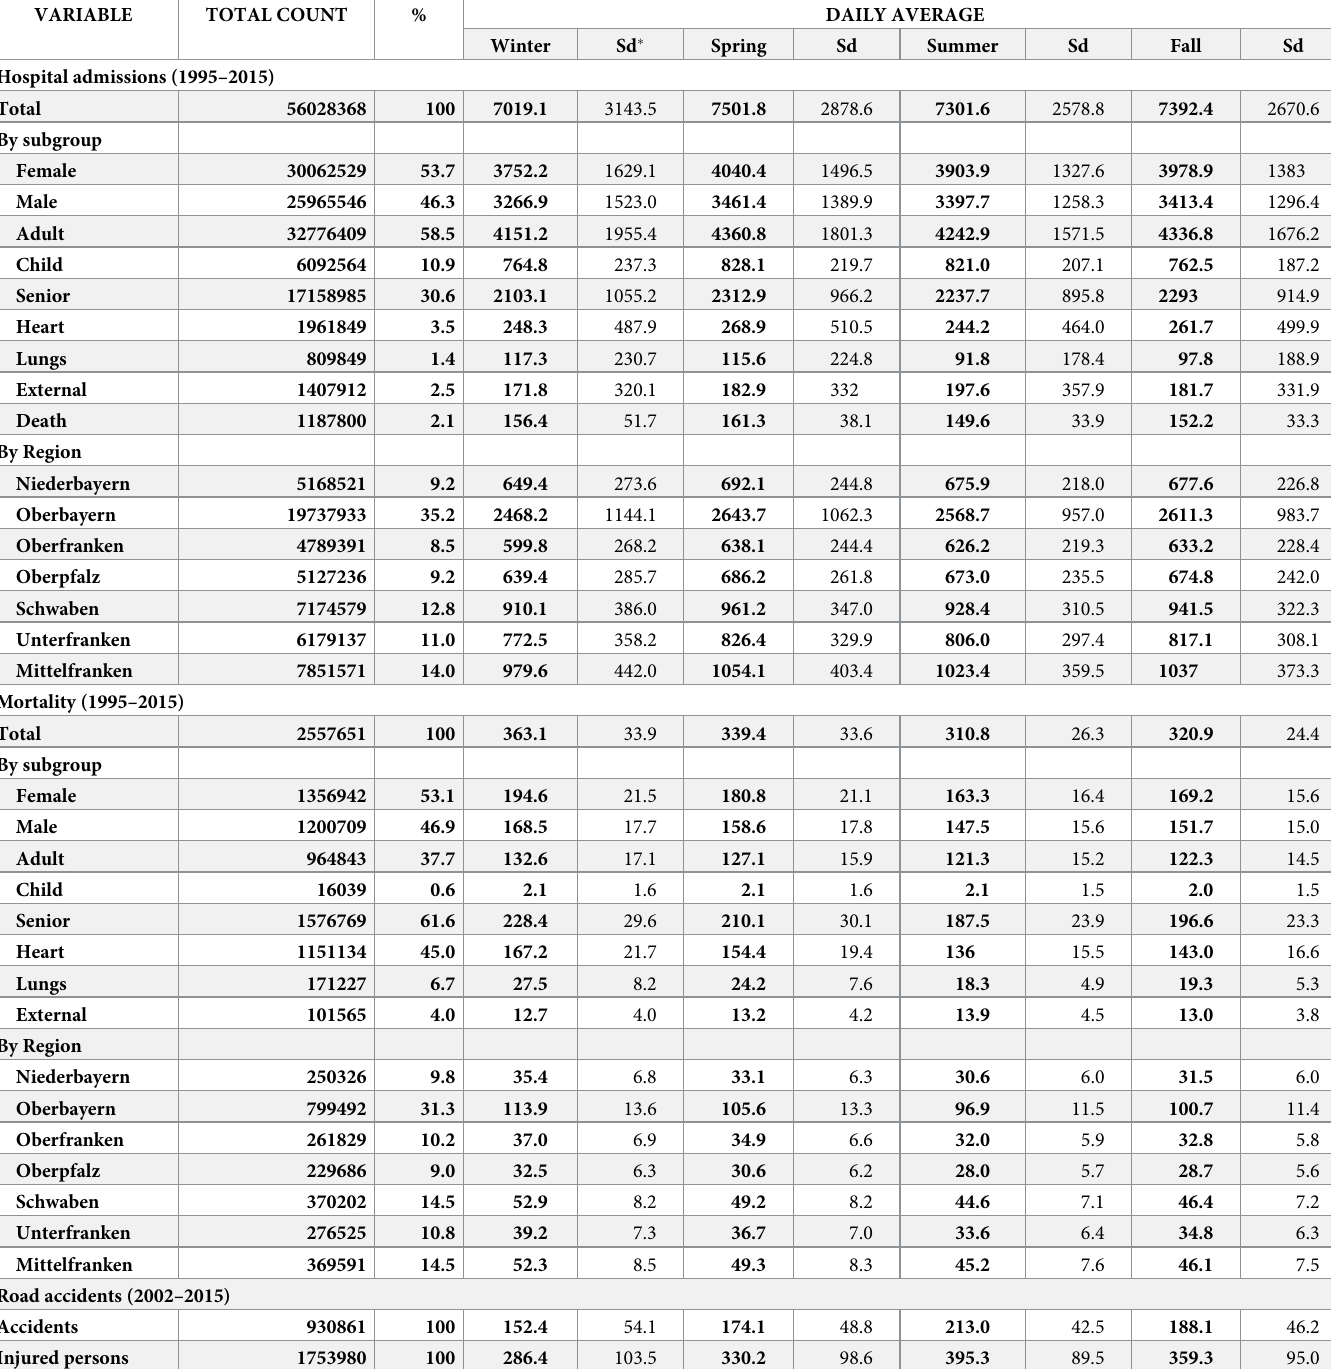
Table 1. Total and average daily hospital admissions, mortality, and road accidents in Bavaria by season as well as by subgroups and regions.